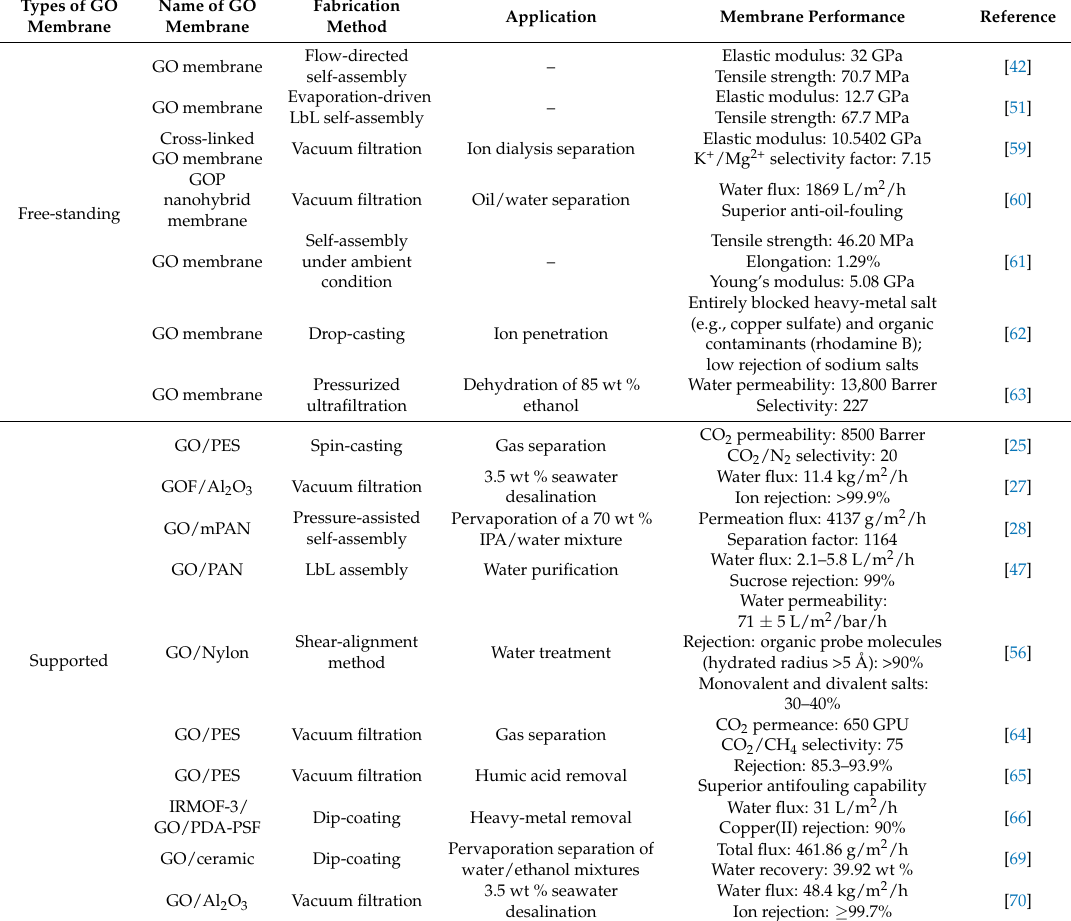
Table 5. Application and separation performance of GO-based